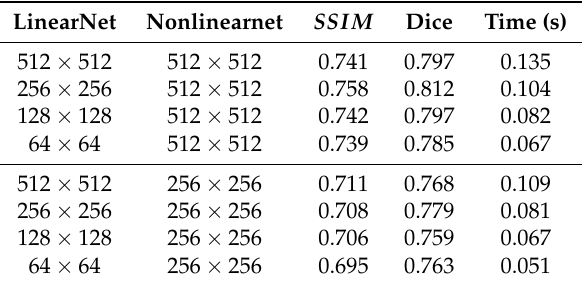
Table 5. Ablation study on varying input image